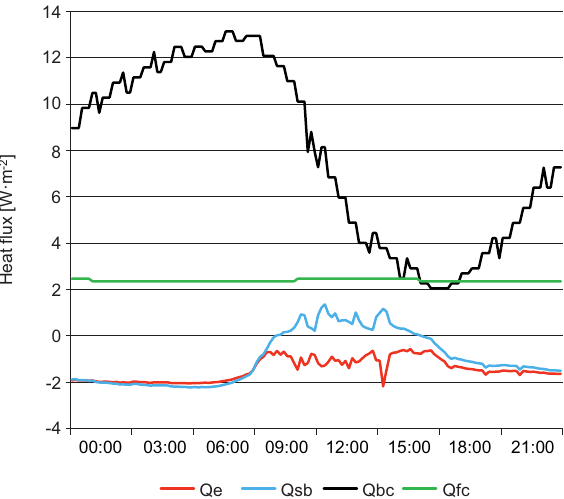
Fig. 5. Non-radiative components of the energy budget during autumn day – 30 September 2013 (see explanations in